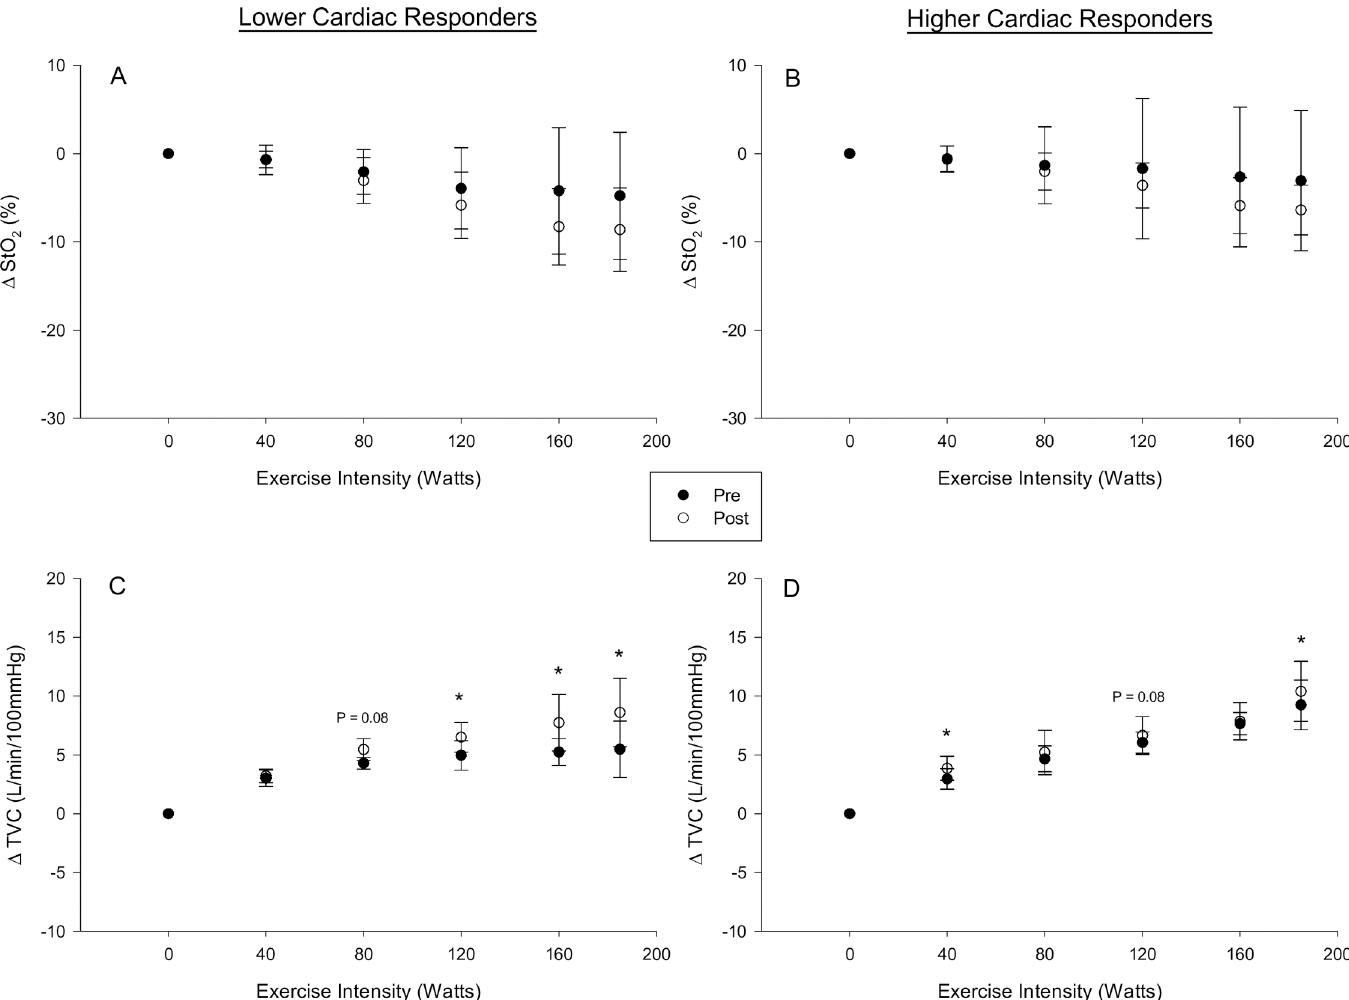
Fig 4. Exercise training and exercise skeletal muscle oxygenation. Panel A-B : Exercising skeletal muscle saturation. Panel C-D : Total vascular conductance. Panel A and C : Lower cardiac responders. Panel B and D : Higher cardiac responders. � denotes statistically significant difference between pre and post-training within a cardiac response group (P < 0.05).